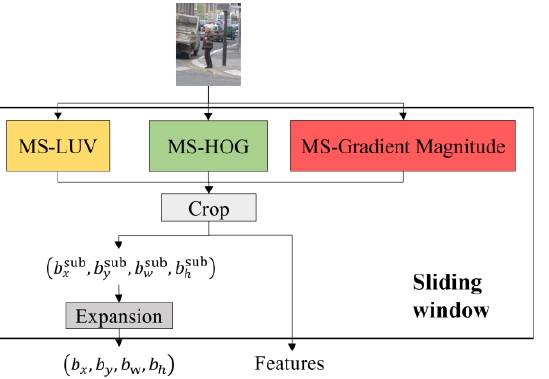
Figure 3. The diagram of the sliding window module. Note that ‘MS’ stands for multiscale.